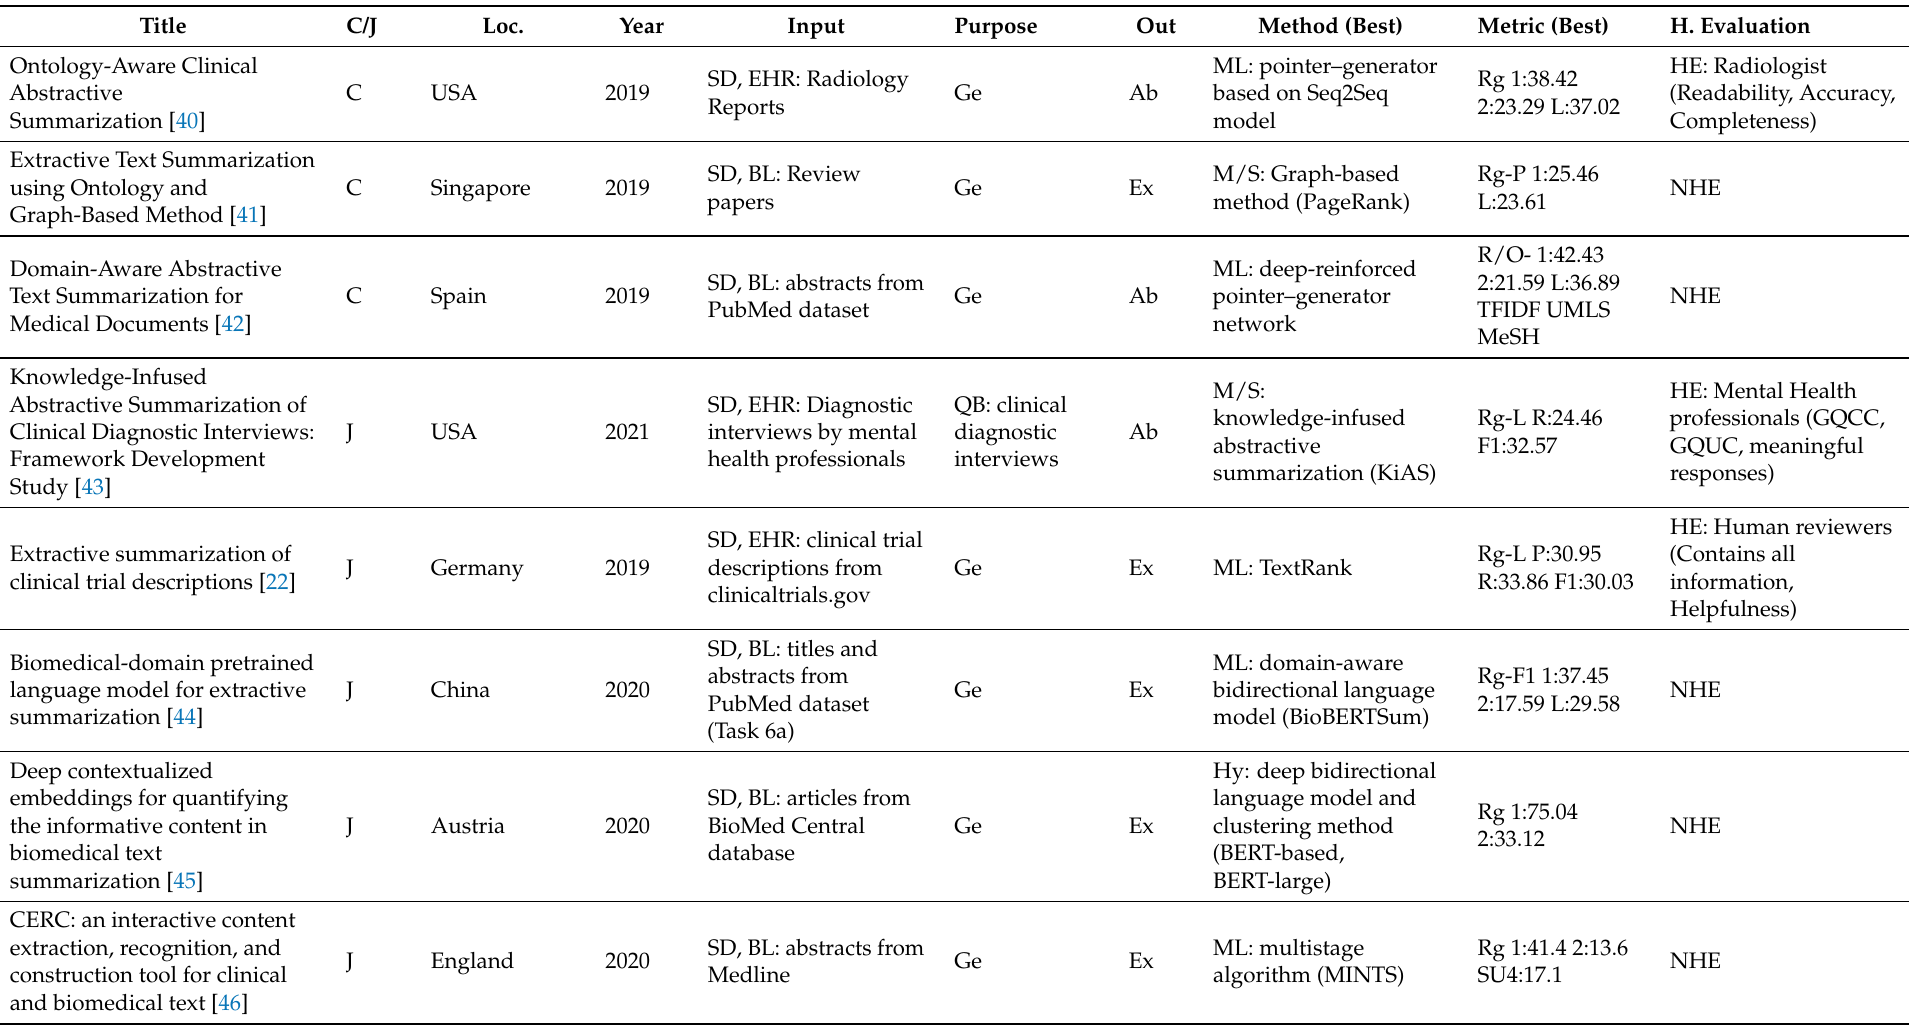
Table 6. Studies included and their characteristics according to summarization